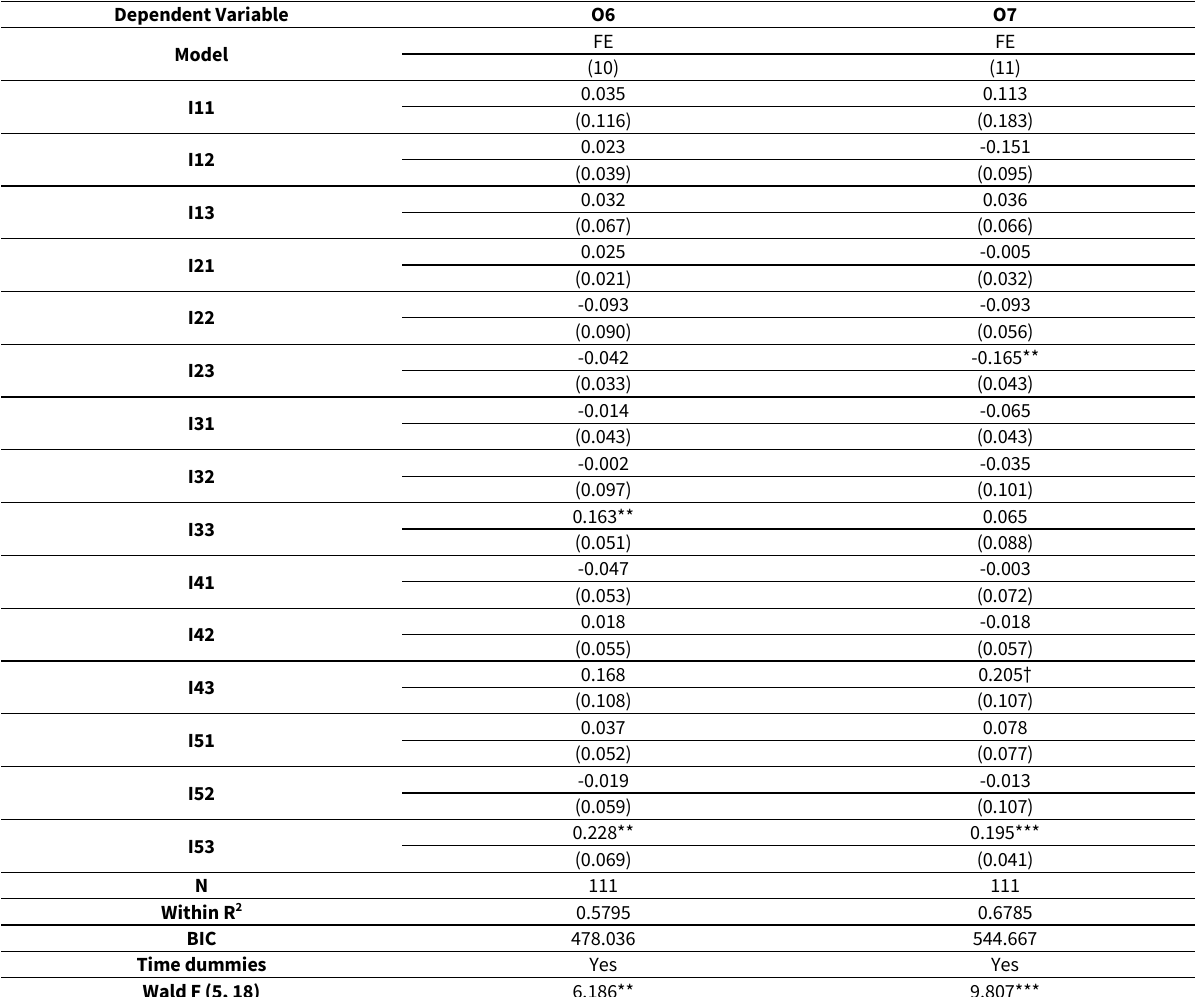
Table 10. Results of Fixed Effects regressions using all input sub-pillars (Eurozone